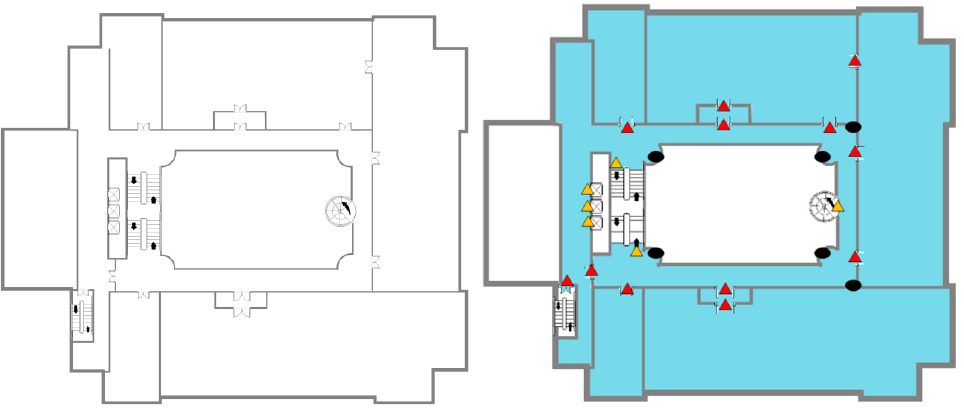
Figure 4. The digital CAD map before ( left ) and after ( right ) being labeled.